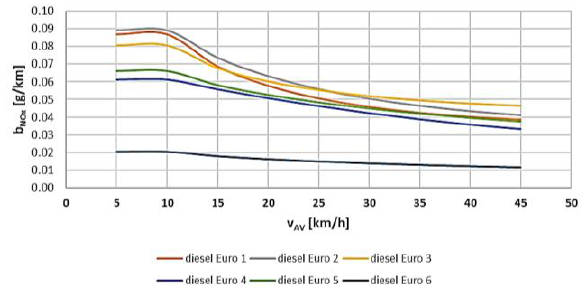
Fig. 12. NO x emission from diesel oil PCs for Euro standards depending on average speed